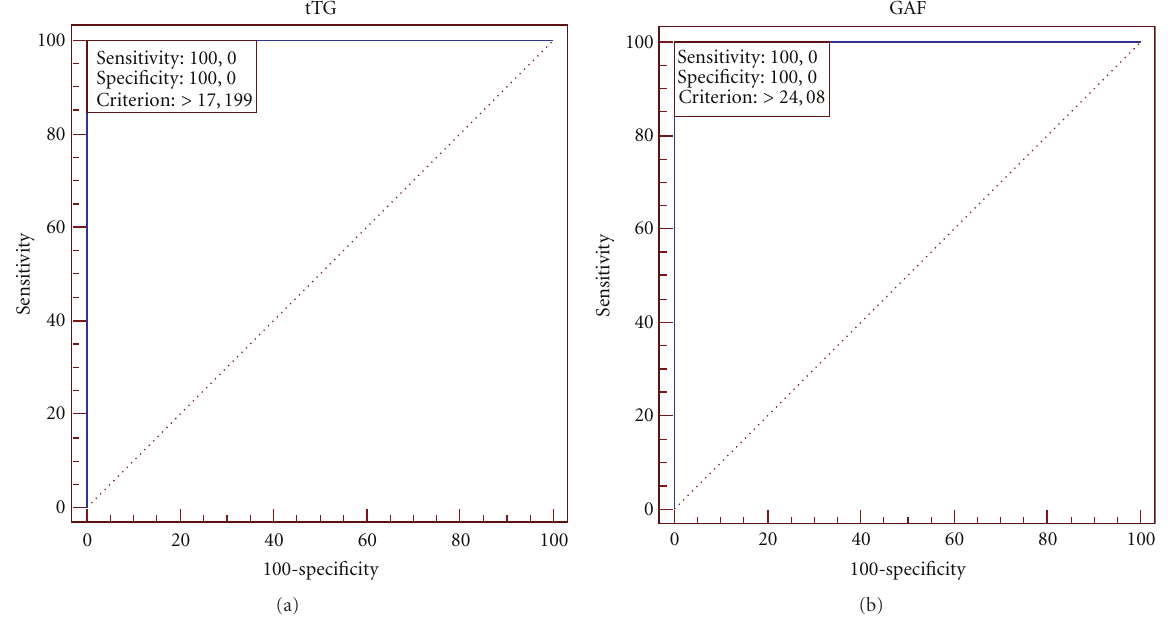
Figure 2: ROC analysis for DH patients and healthy controls. (a) shows the plot for Anti-tTG IgA ELISA, and (b) shows Antigliadin (GAF- 3X) IgA ELISA. The cuto ff point marked as criterion (17.199 and 24.08,